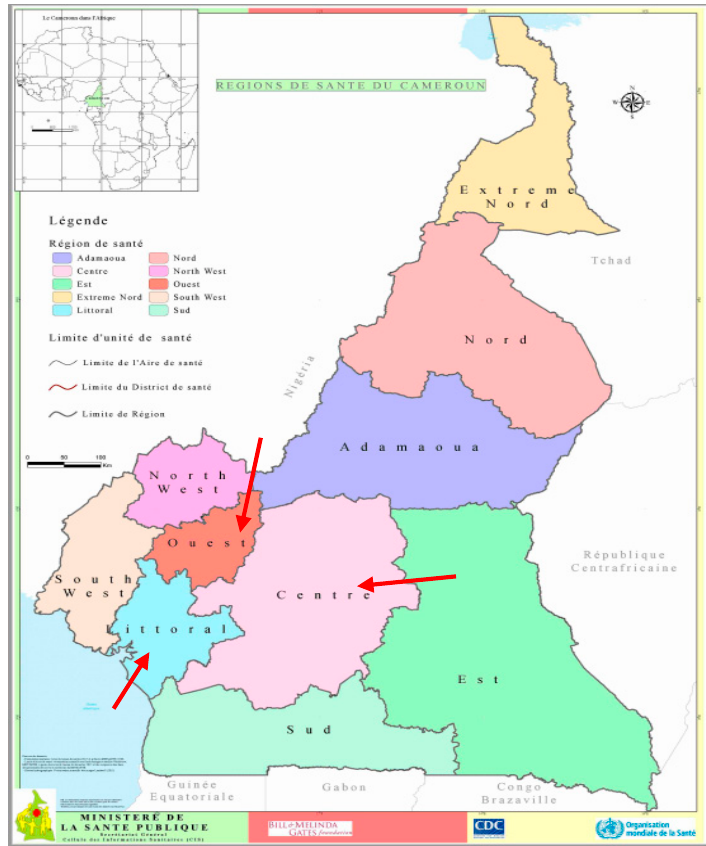
Figure 1. Map of Cameroon showing the study areas: The Regions of the West, the Centre and the Littoral. (Source: 2016 © Ministry of Public Health; https://www.dhis-minsante-cm.org/portal/. Administrative Research Authorization N° 631-1315)